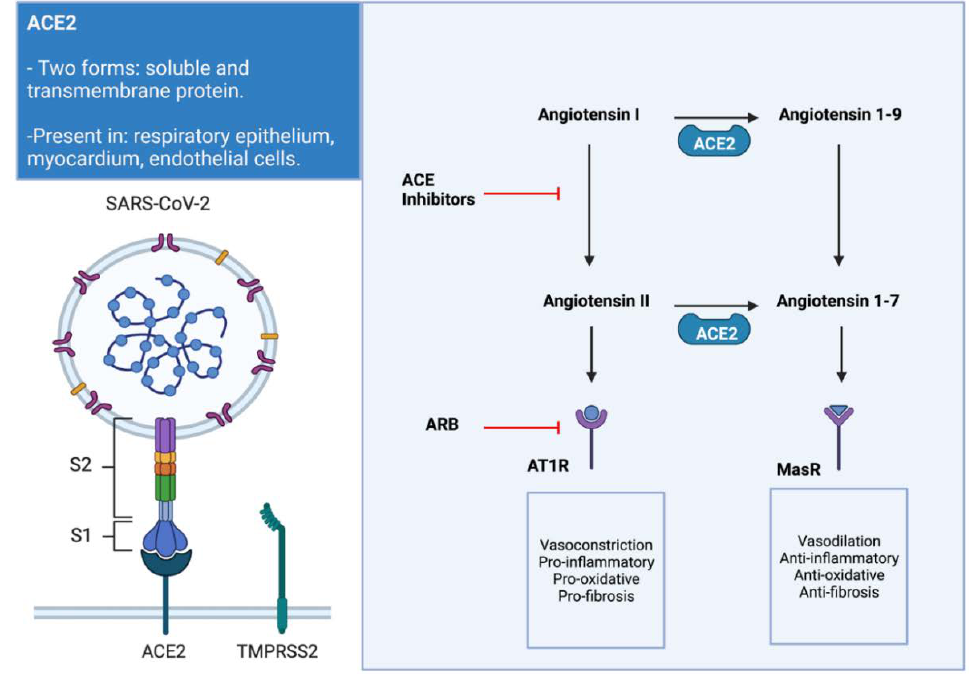
Figure 2. Relationship of angiotensin-converting enzyme 2 (ACE2) with SARS-CoV-2. SARS-CoV-2 binds to the cells through the transmembrane ACE2, which is present in several tissues. After the union to the receptor, the entrance to the cell is facilitated by another transmembrane protein (TPMPRSS2). Furthermore, the possible downregulation of the ACE2 activity with decreased conversion of angiotensin II to angiotensin 1–7 leads to detrimental effects in the myocardium and other systems. Sustained stimulation of the angiotensin receptors (AT1R) by angiotensin II and decreased stimulation of the angiotensin 1–7 receptor (MasR) is associated with adverse myocardial remodeling for predominance of profibrotic and pro-oxidative mechanisms. In addition, the sites of action of the ACE inhibitors and angiotensin receptor blockers (ARB) can be seen in the figure. These two drugs help to reduce the deleterious effects of the RAAS classic pathway overstimulation.